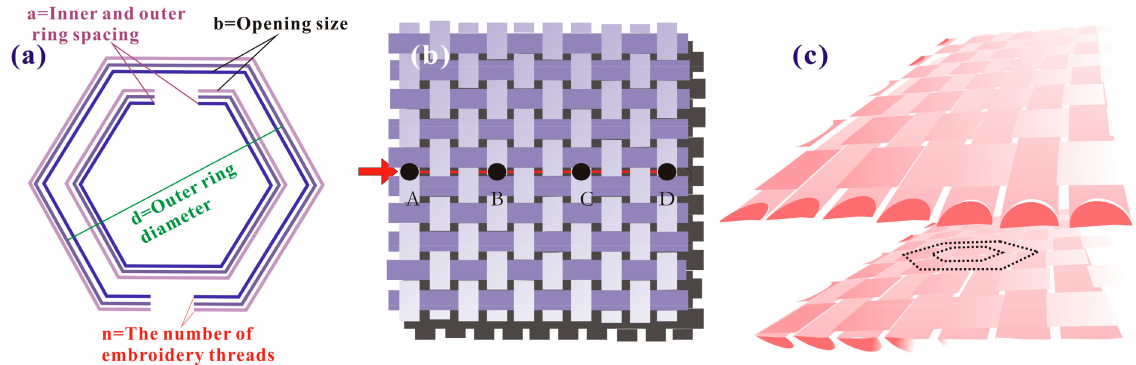
Figure 2. SRR model and invisible embroidery method. ( a ) SRR model, ( b ) Invisible functional embroidery trajectory, ( c ) Pattern position of invisible functional embroidery.